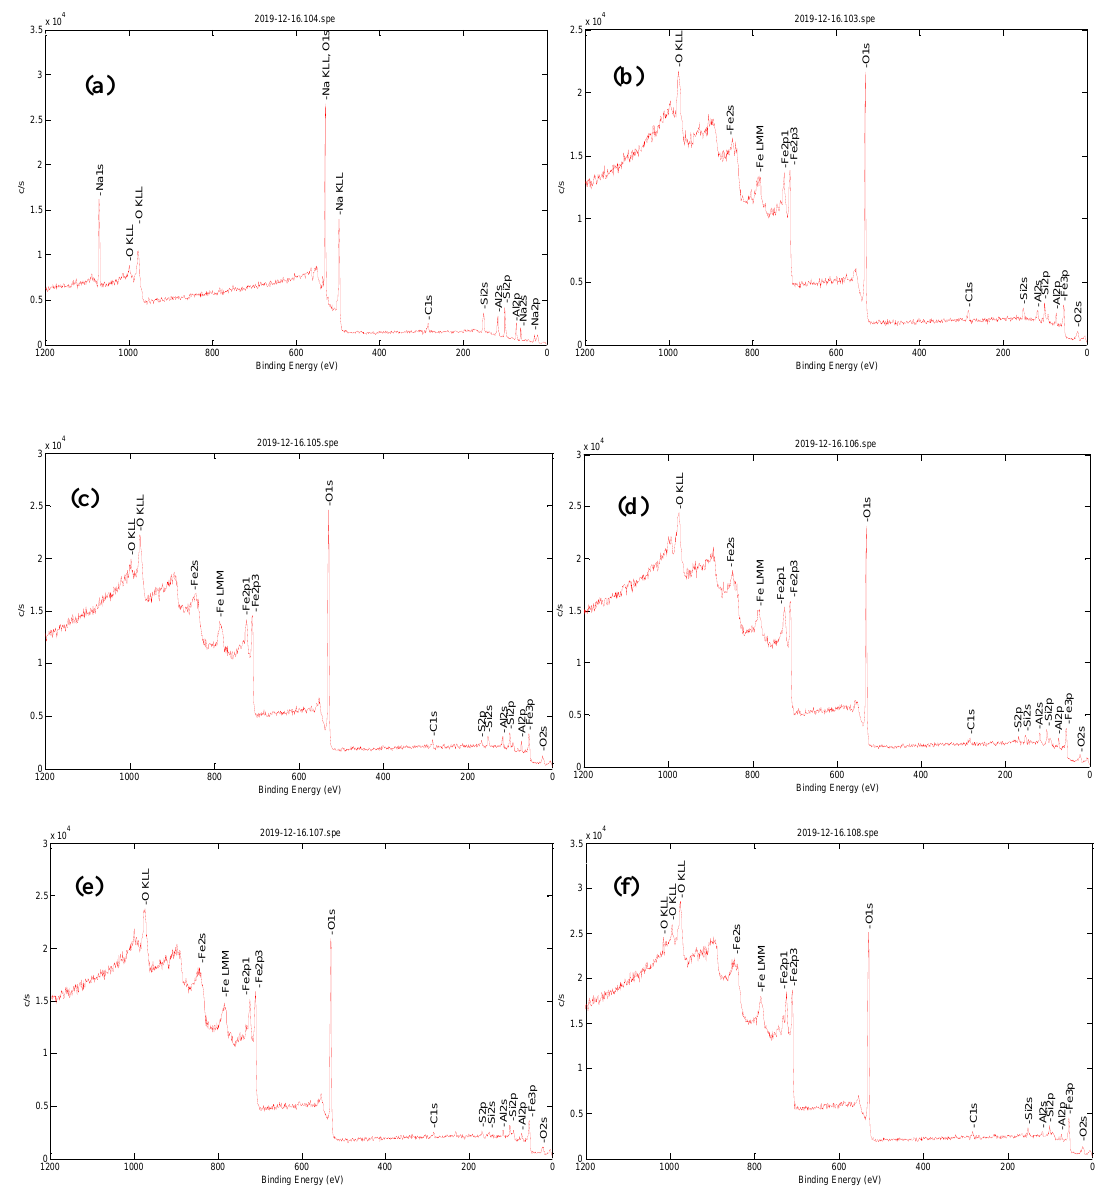
Figure 2. XPS spectra of ( a ) bare zeolite, ( b ) FeZ-1.5, ( c ) FeZ-3, ( d ) FeZ-5, ( e ) FeZ-8, and ( f ) FeZ-10 composites.